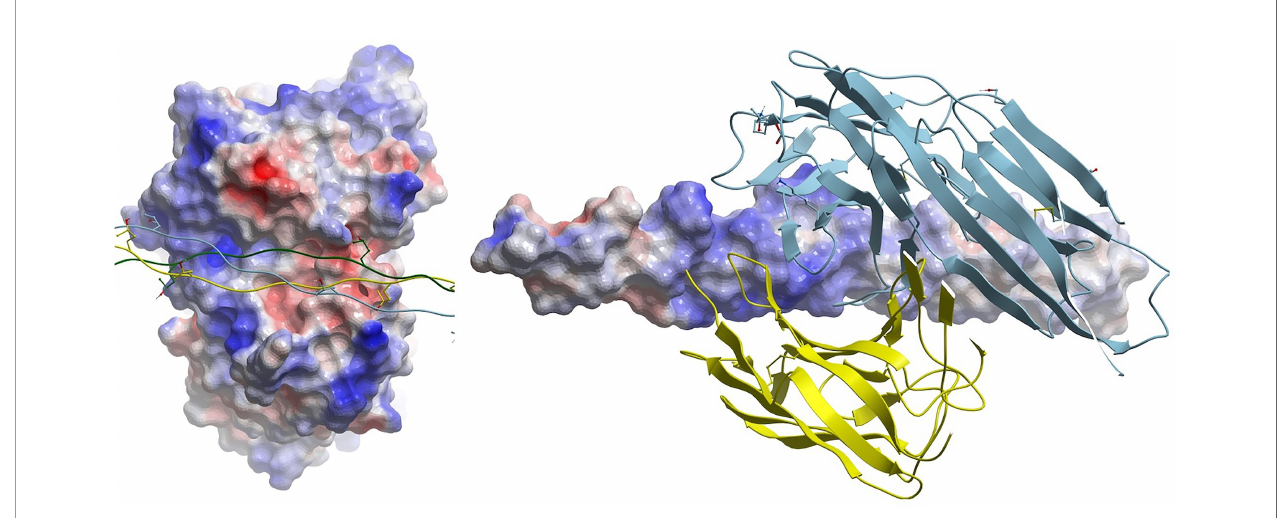
FIGURE 2 | (Left) Electrostatic surface of antigen (epitope) combining site of mAb CIIC1. Triple-helical collagen C1 epitope is shown as a ribbon with some side chains displayed in stick form. (Right) Cognate electrostatic surface of epitope. The mAb is shown in ribbon